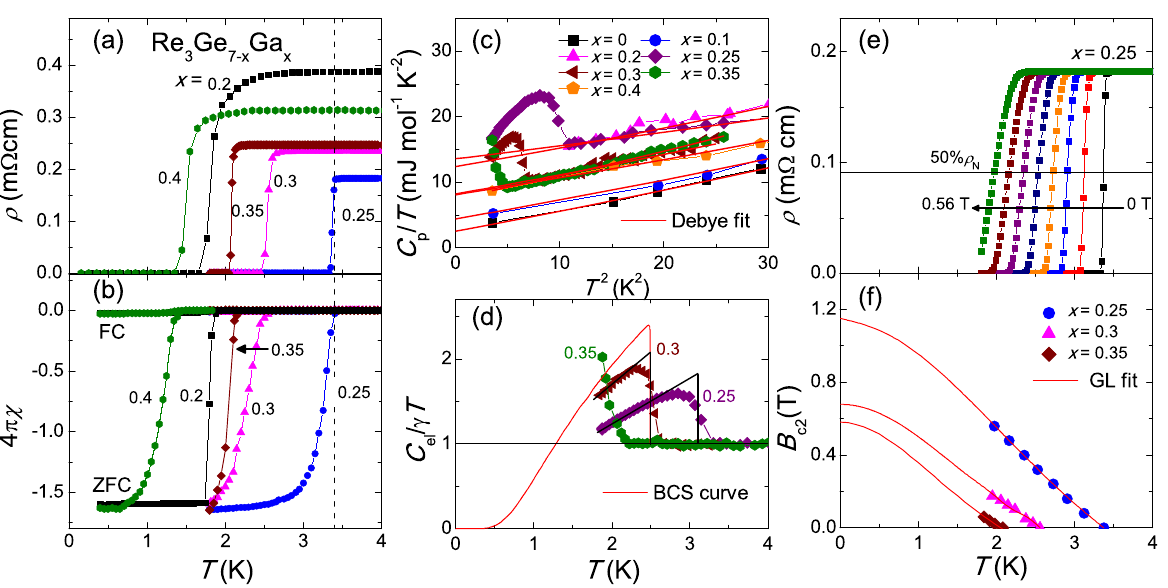
Fig. 4 Superconducting transition and upper critical fi eld of Re 3 Ge 7 − x Ga x . a , b Low-temperature resistivity and magnetic susceptibility for Re 3 Ge 7 − x Ga x with 0.2 ≤ x ≤ 0.4, respectively. The vertical dashed line is a guide to the eyes. c Low-temperature speci fi c-heat C p data for all the Re 3 Ge 7 − x Ga x samples plotted as C p / T versus T 2 . The solid lines are fi ts by the Debye model. d Temperature dependence of normalized electronic speci fi c-heat for the samples with 0.25 ≤ x ≤ 0.35. The back lines are energy conserving constructions to estimate the speci fi c-heat jump and the red line denotes the theoretical BCS curve. e Temperature dependence of resistivity under various fi elds up to 0.56 T for the sample with x = 0.2, and the fi eld increment is 0.08 T. The horizontal line and arrow indicate the 50% drop of normal-state resistivity and fi eld increasing direction, respectively. f Upper critical fi eld versus temperature phase diagram for the samples with 0.25 ≤ x ≤ 0.35. The solid lines are fi ts to the data by the Ginzburg – Landau model.